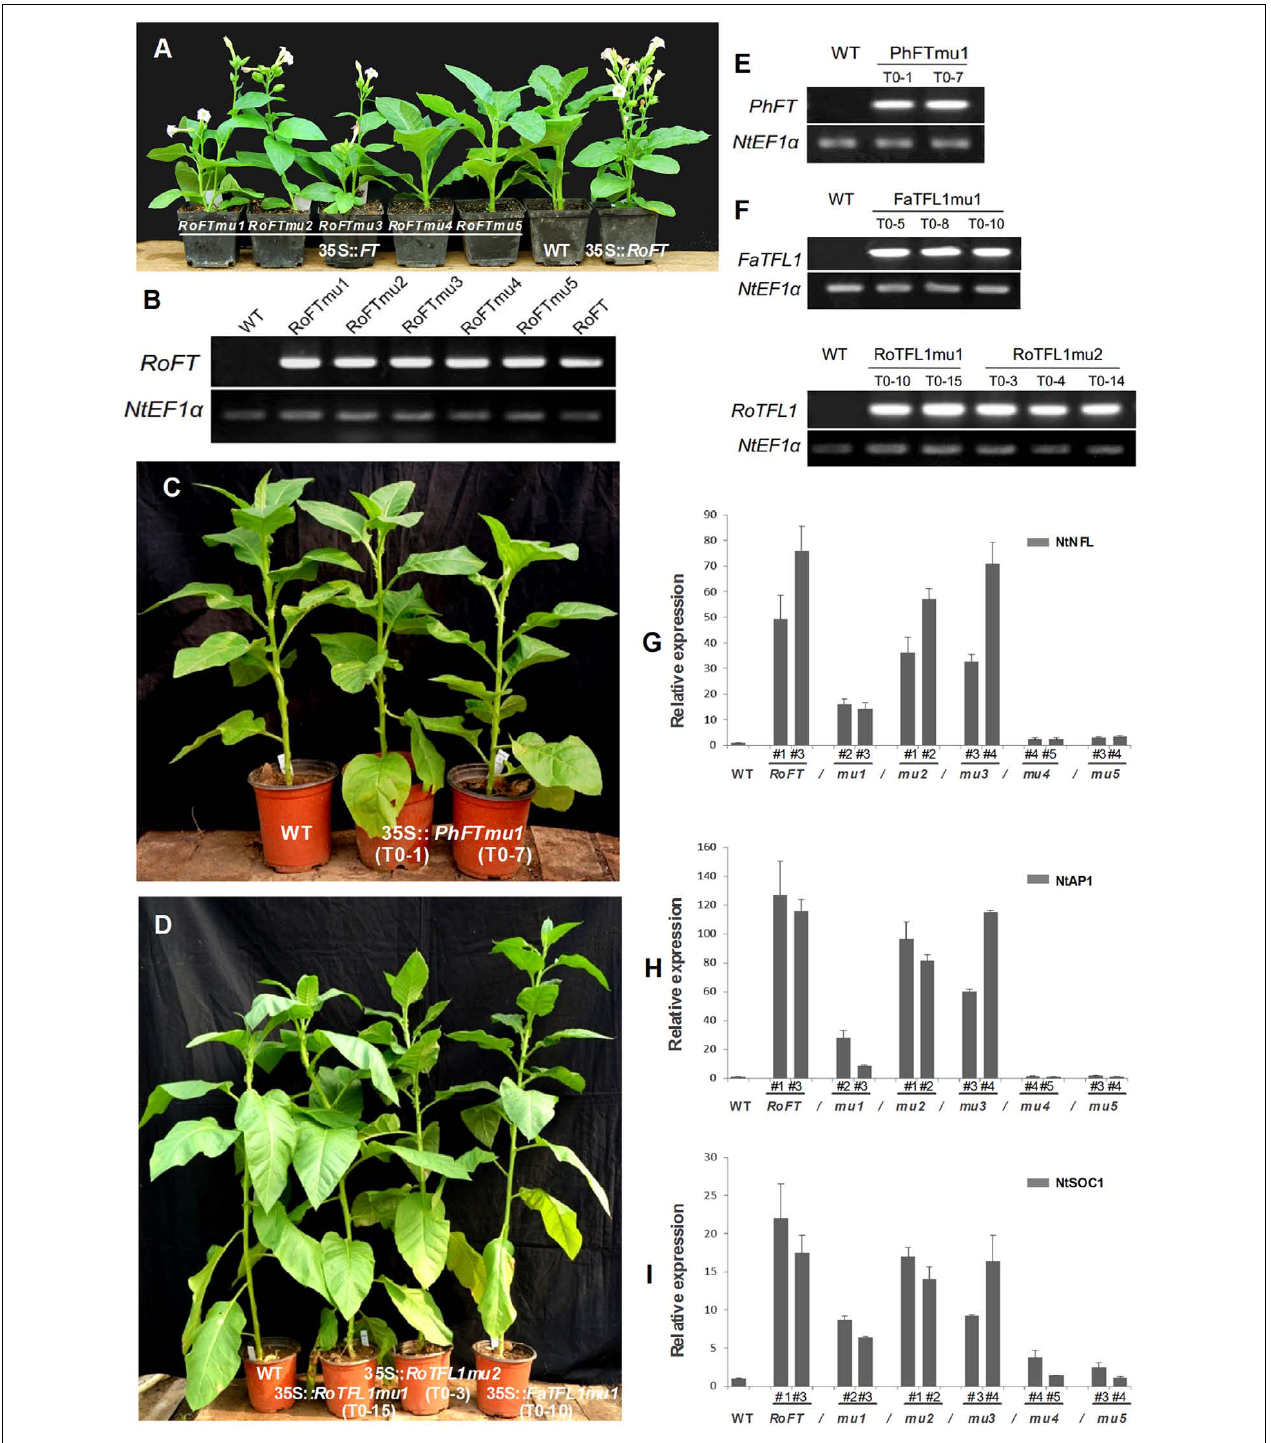
FIGURE 4 | Phenotypic analysis of transgenic tobacco plants harboring different FT/TFL1 homologs. (A) From left to right, 35S:: RoFTmu1-5 , wild-type and 35S:: RoFT plants, respectively, after growth for 45 days. (B) RT-PCR analysis to confirm the transgenic lines. (C) From left to right are wild-type, and transgenic plants harboring PhFTmu1 (two lines) after growth for 3 months. (D) From left to right are wild-type, transgenic plants harboring RoTFL1mu1 , RoTFL1mu2, and FaTFL1mu1 after growth for 4 months. (E,F) RT-PCR analysis to confirm the transgenic lines. (G–I) qRT-PCR analysis of endogenous flowering genes in 45-day-old seedlings of transgenic and wild-type tobacco. The transcript levels of: (G) NtNFL , (H) NtAP1, and (I) NtSOC1 in different transgenic tobacco lines harboring various point mutations of FT . In this analysis, NtEF1 α was used as a reference transcript. Three biological replications were performed randomly for each transgenic line.